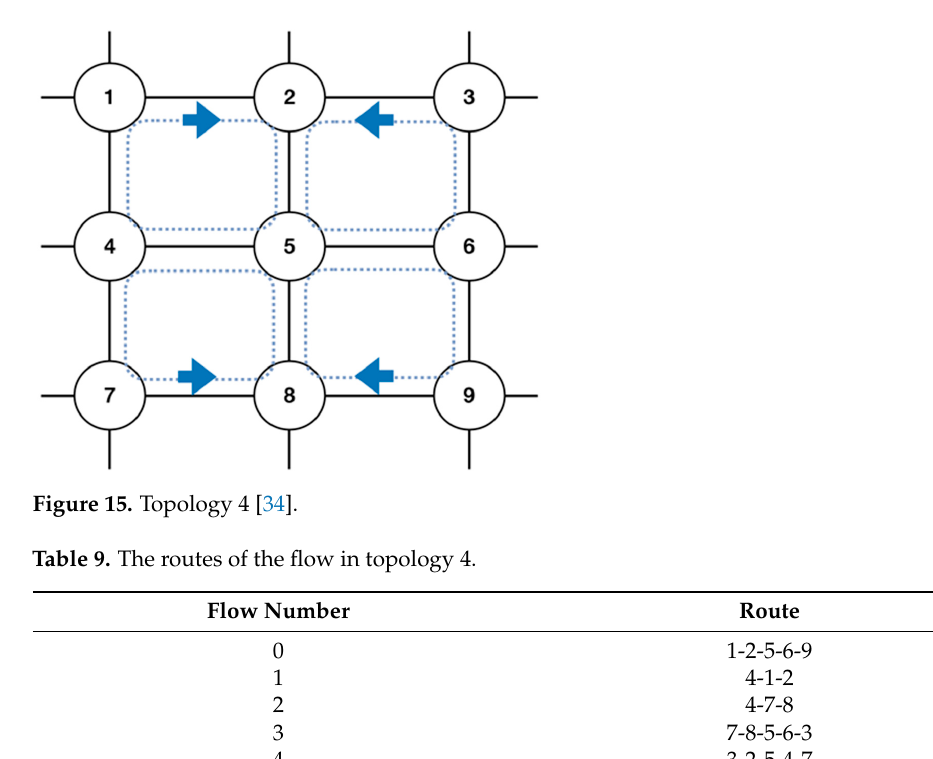
Figure 14. Training result of RL model in topology 3.